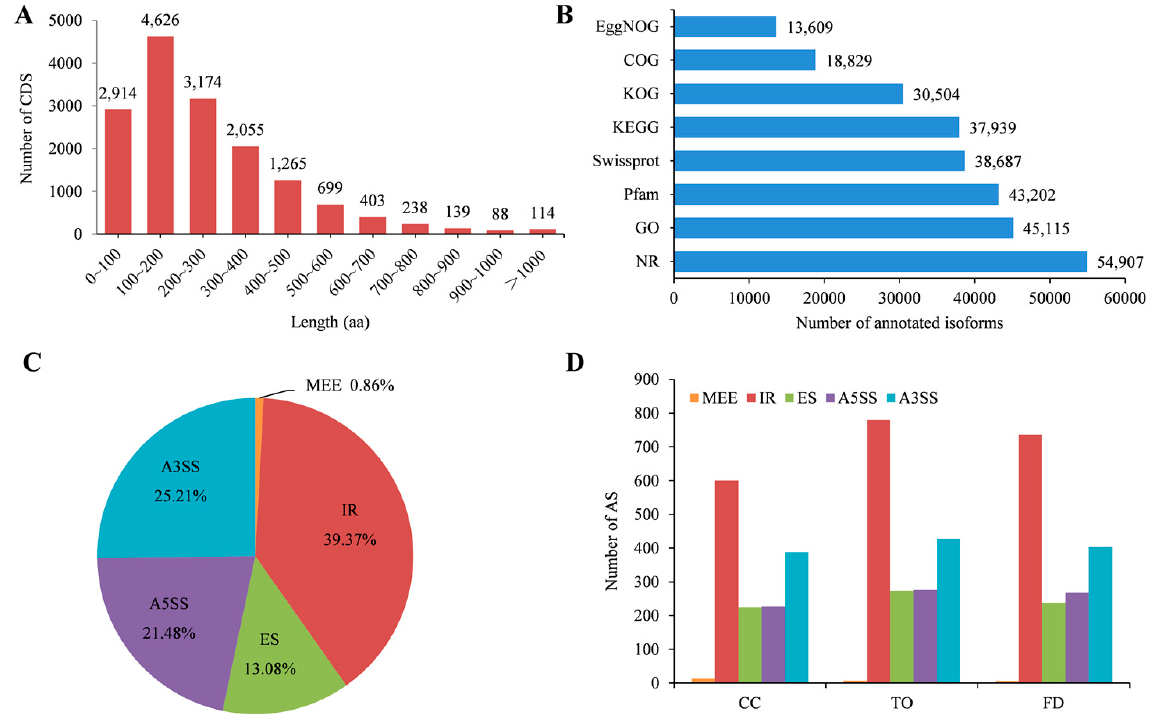
Figure 2. Characteristics of the transcripts and alternative splicing events. ( A ): Length distribution of all predicted peptides. ( B ): Functional annotations of new isoforms using eight different data- bases. ( C ): Summary of all alternative splicing events. ( D ): Alternative splicing events in the CC, TO, and FD rootstocks .